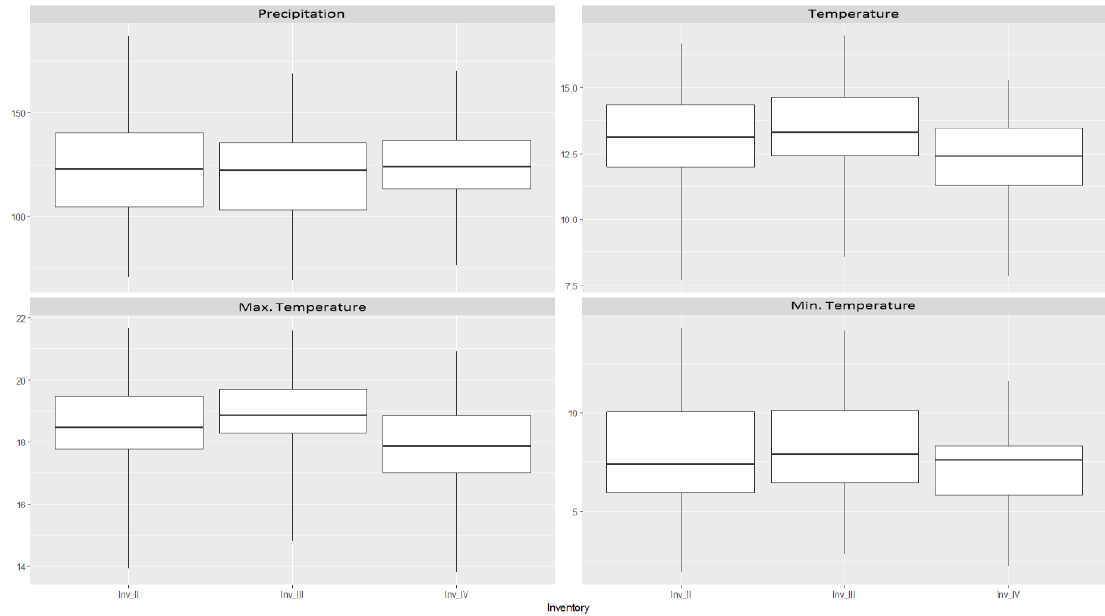
Figure 1. Boxplot summary of meteorological variables during the different inventories. From top to bottom: mean annual rainfall (Ppr) in mm; mean annual temperature (Tas) in ◦ C, mean of the maximum temperatures of the warmest month (Tas MAX) in ◦ C, mean of minimum temperatures of the coldest month (Tas MIN) in ◦ C.